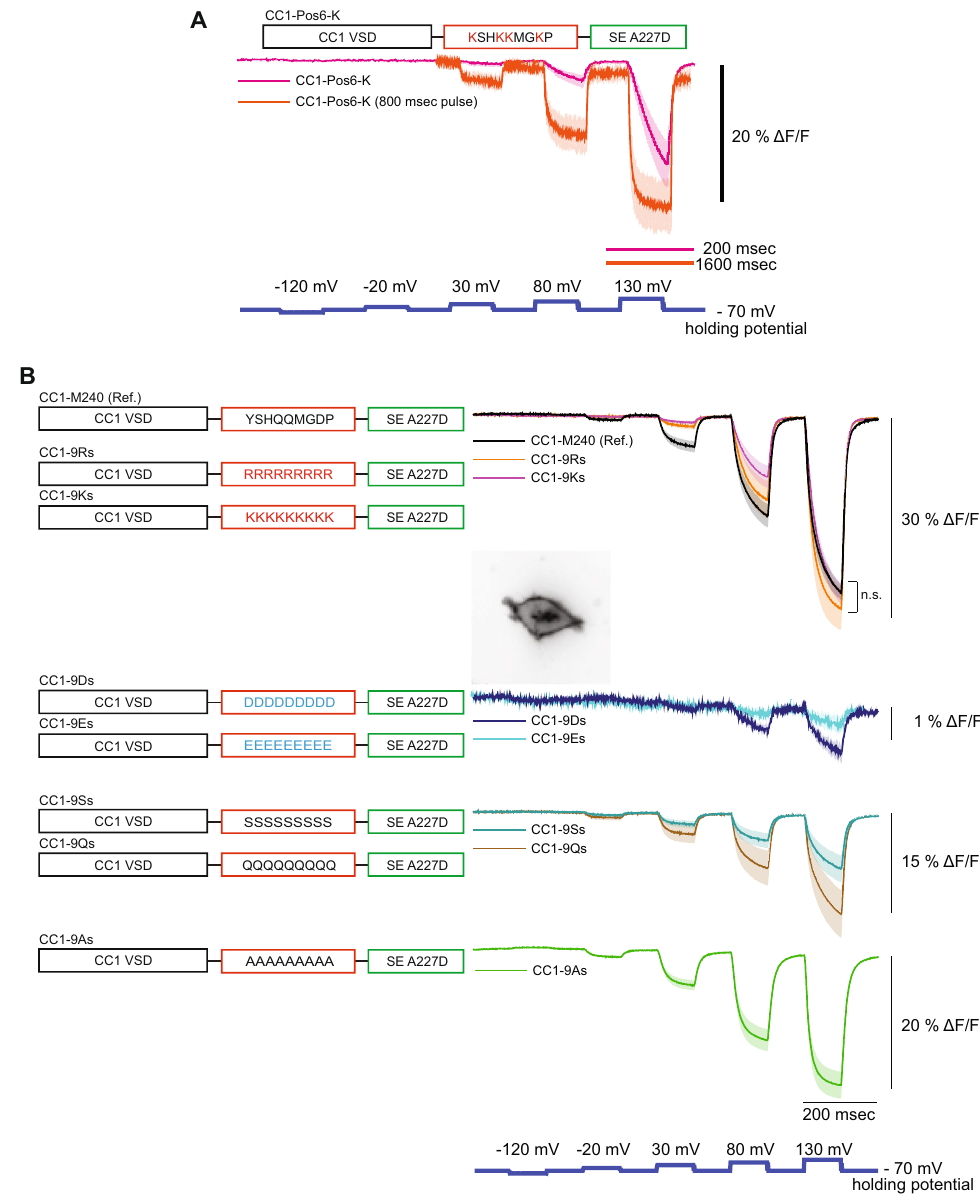
Figure 2. Effects of altered linker charge composition. ( A ) The lysine version of CC1-Pos6, CC1-Pos6-K, showed a reduced signal size and slower response. ( B ) Linker variants consisting of a single amino acid type. Positively charged linkers had the least effect on signal size for a 200 mV depolarization and did not show statistical difference compared to CC1-M240 (n.s.: not significant). Negative amino acid linkers reduced the signal size nearly 15-fold. Inset shows an HEK 293 cell expressing CC1-9Ds. Polar linkers consisting of serine or glutamine reduced the signal by roughly 50%. A linker consisting entirely of alanines reduced the signal size by about a third. The shaded area denotes standard error of the mean. The number of cells averaged for each construct; CC1-M240: 4, CC1-Pos6-K: 4, CC1-Pos6-K (800 msec pulse): 4, CC1-9Rs: 4, CC1-9Ks: 4, CC1-9Ds: 3, CC1-9Es: 3, CC1-9Ss: 4, CC1-9Qs: 4, CC1-9As: 5. Scale bar = 20 µ m. In Fig. 2B, no significant difference (n.s.) was found between the three